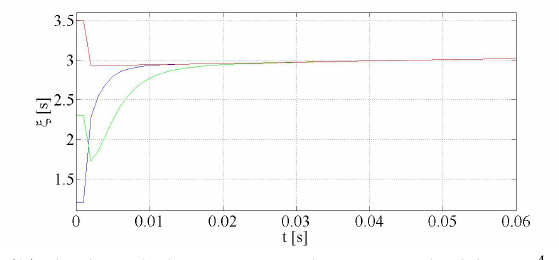
Figure 13. The clocks behavior of the three nodes.